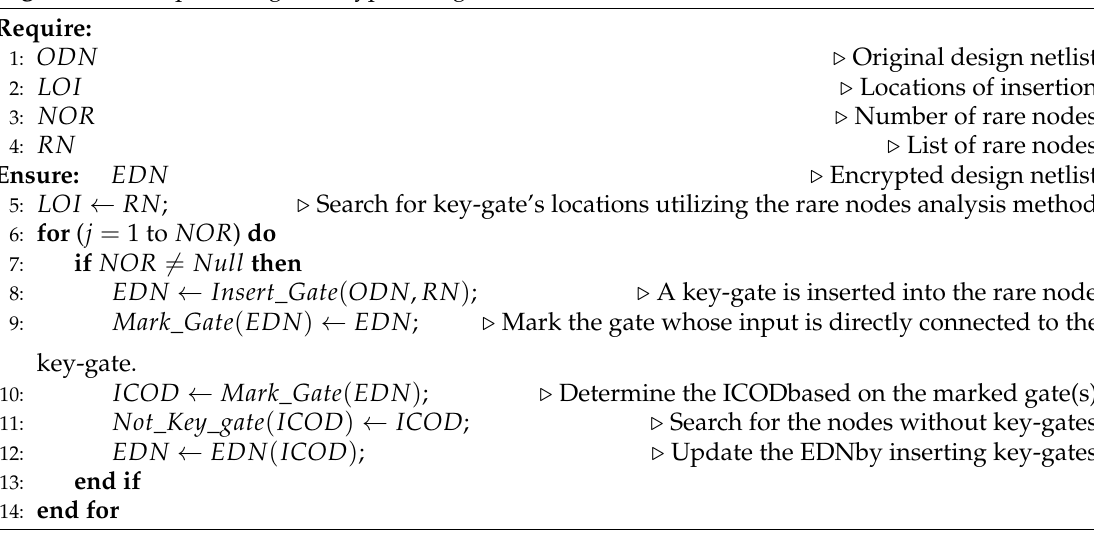
Algorithm 2 Proposed logic encryption